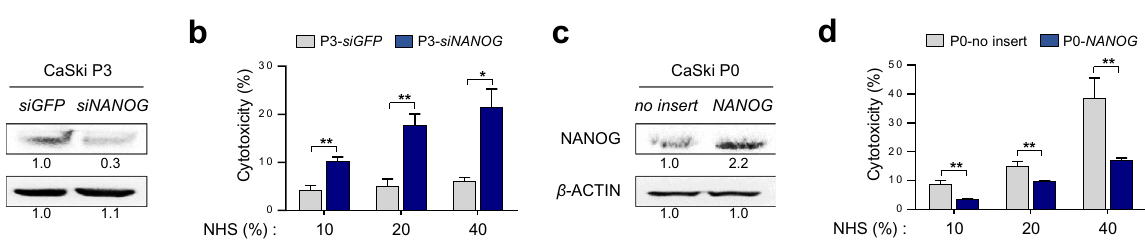
Figure 2. NANOG contributes to CDC resistance of tumor cells. ( a , b ) CaSki-P3 cells were transfected with siRNAs targeting GFP or NANOG. ( c , d ) CaSki P0 cells were stably transfected with an empty vector (no insert) or NANOG. ( a , c ) The level of NANOG protein was analyzed by Western blot. β -ACTIN was included as an internal loading control. Numbers below blot images indicate the quantitative value, as measured by fold change. Original blots were presented in Supplementary Fig. S7 and Fig. S8 ( b , d ) CDC was measured by LDH release assay after incubation with the indicated concentrations of NHS. All experiments were performed in triplicate, and error bars represent standard deviations from the mean. Differences in cytotoxicity level were statistically tested using the Student’s t-test ( a , c ), or two-way ANOVA ( b , d ): * p < 0.05; ** p <